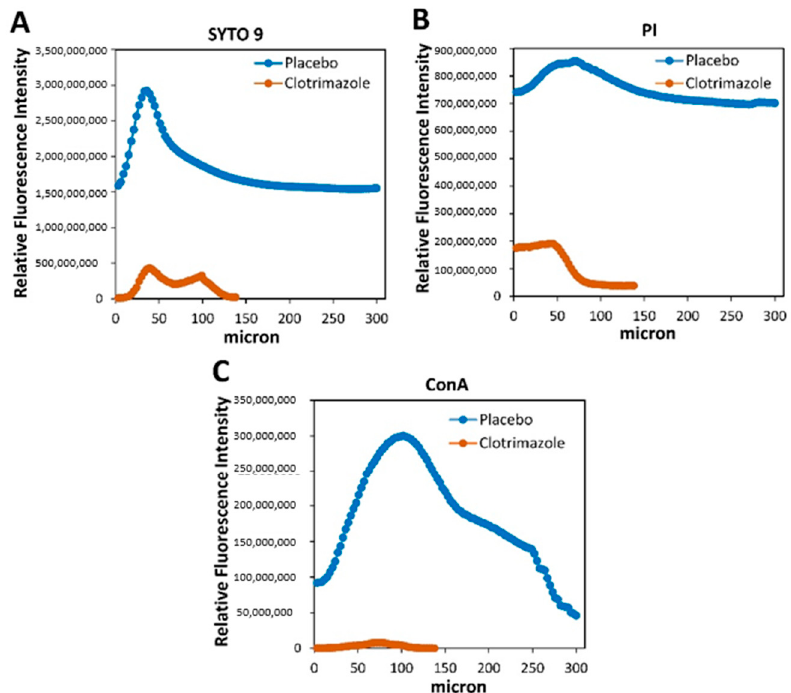
Figure 7. Quantification of the relative fluorescence intensities of SRV-CTZ- versus placebo-SRV-coated VPs analyzed on SDCM. The relative fluorescence intensities of triplicate images captured on spinning disk confocal microscope were analyzed using the NIS-Element AR software. ( A ) SYTO 9 staining. ( B ) PI staining. ( C ) AlexaFluor 647 -conjugated ConA staining. N = 1.